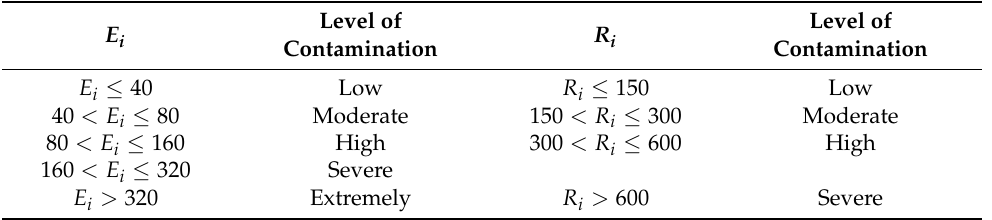
Table 4. Classifying standards of the potential ecological risk index and pollution degree of heavy